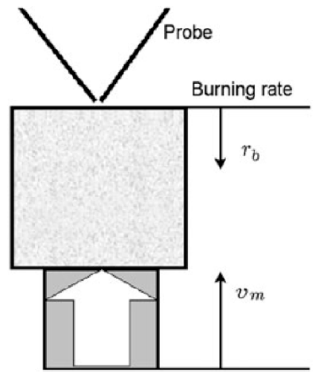
Figure 5 . The experimental setup for studying the flame structure.